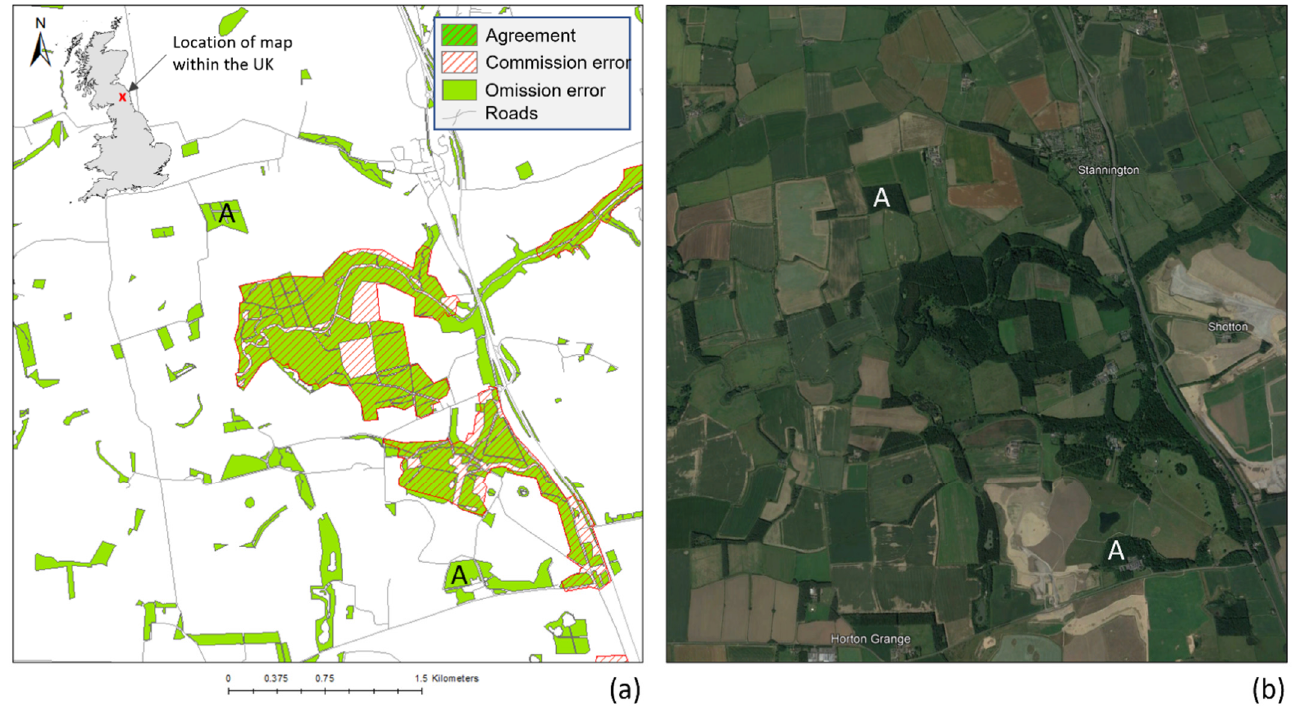
Figure 2. ( a ) OS 2019 forest (reference in green) vs. 2018 Corine (test in red stripe), ( b ) Google Earth imagery date 17 July 2021. imagery date 17 July